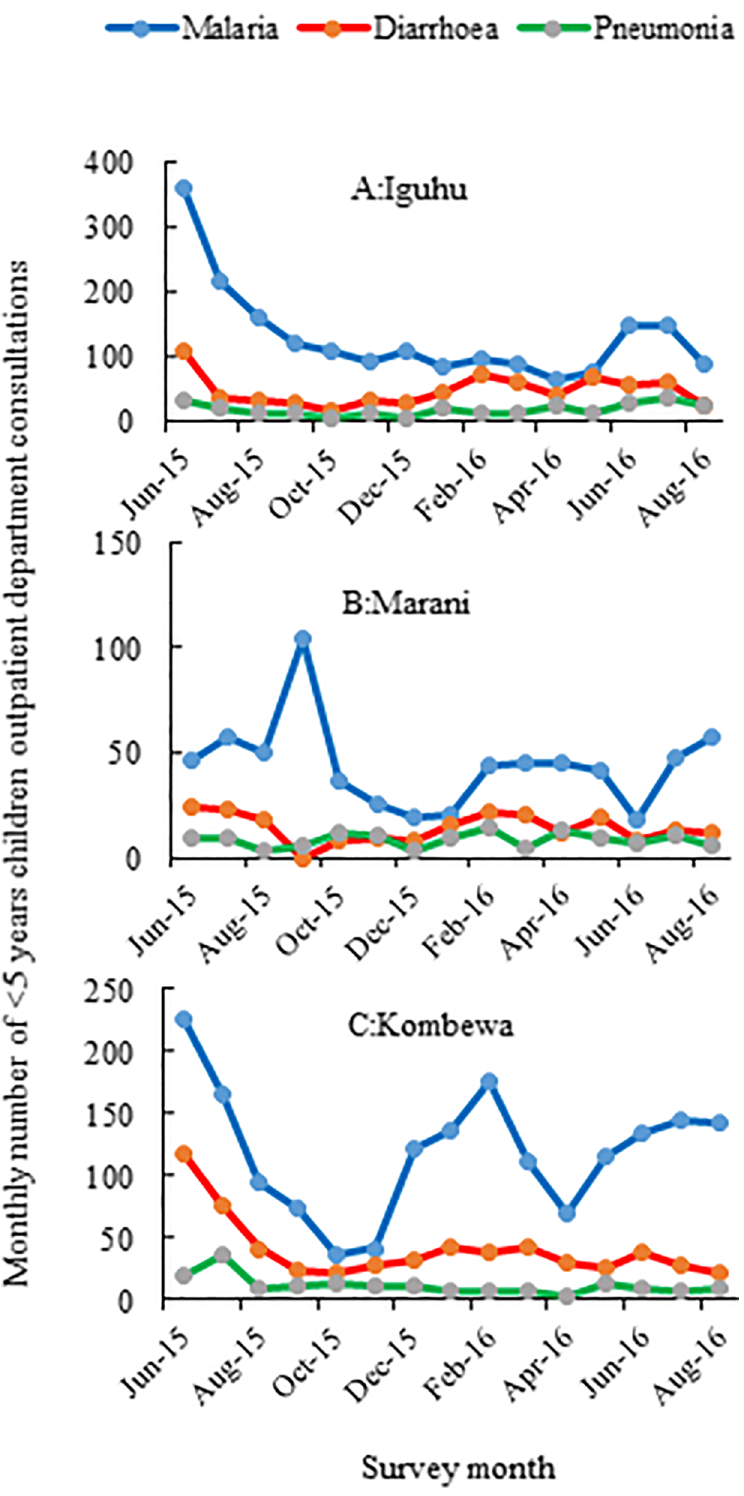
Fig 3. Monthly cases of confirmed malaria and other common diseases (diarrhoea and pneumonia) among under five children attending outpatient clinics from June 2015 to August 2016 in three hospital of Western Kenya.